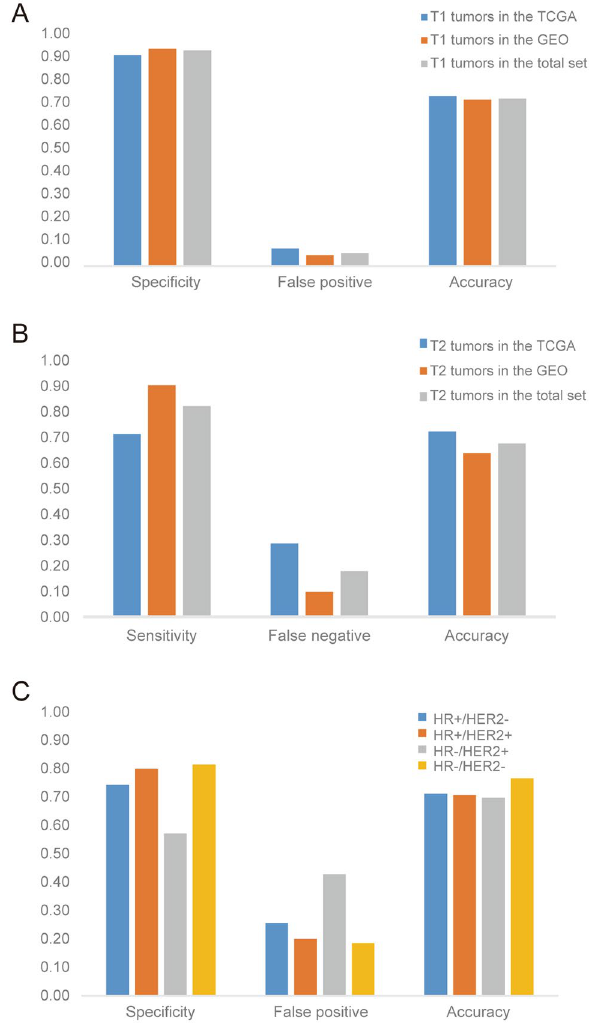
Figure 4. Effectiveness of the model in different T stages and different molecular types of breast cancer. ( A , B ) Female patients with early (T1 or T2) breast cancer; ( C ) different breast cancer molecular subtypes in the total